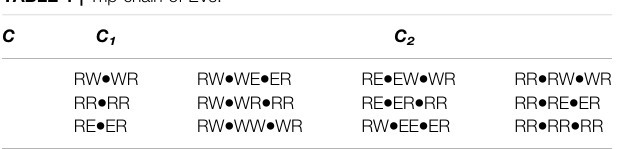
TABLE 1 | Trip chain of